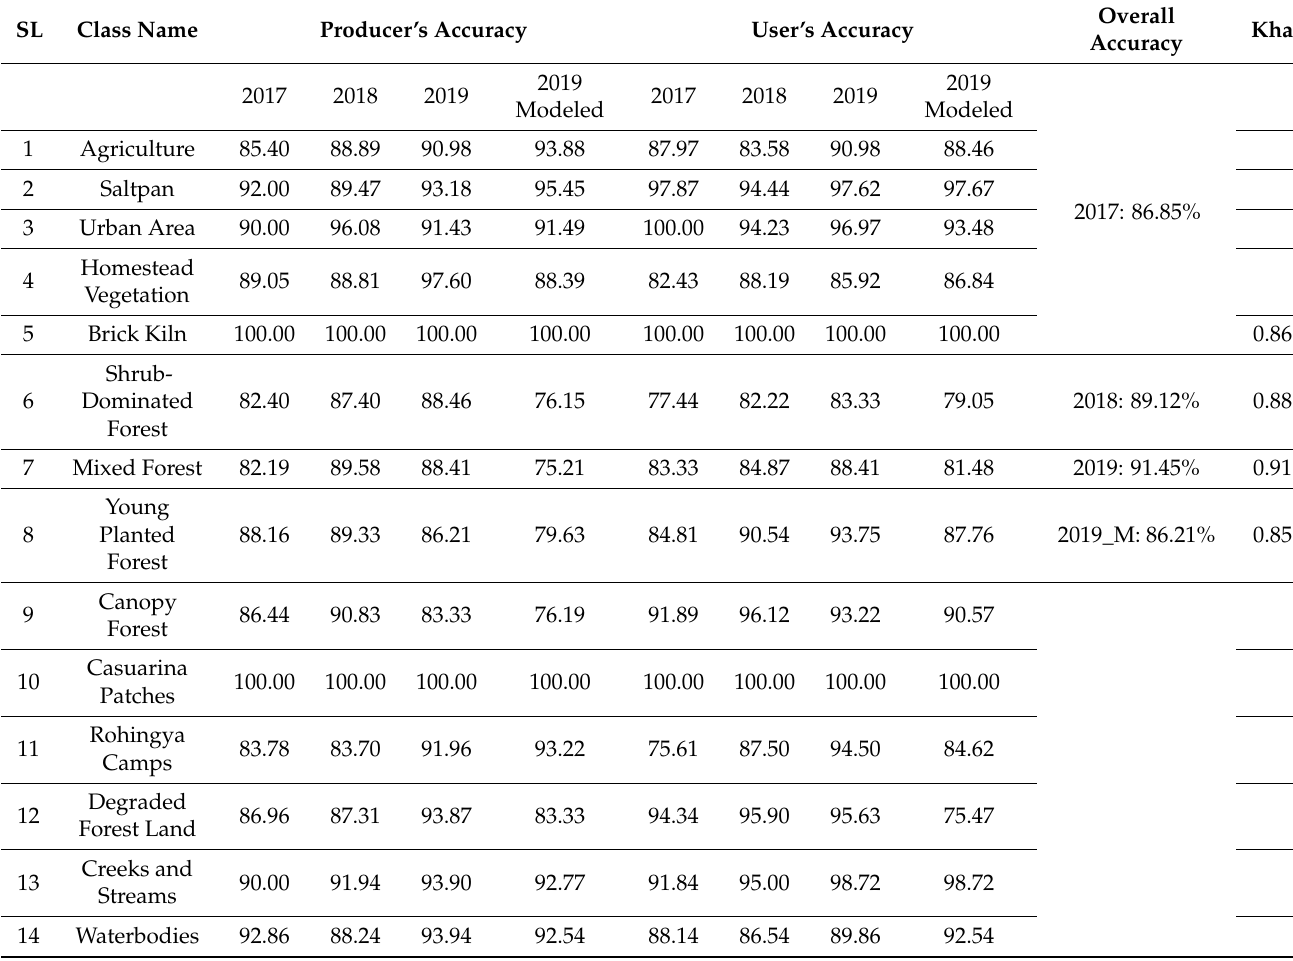
Table A1. Accuracy assessment for forest cover classification for the years of 2017, 2018, 2019 and 2019